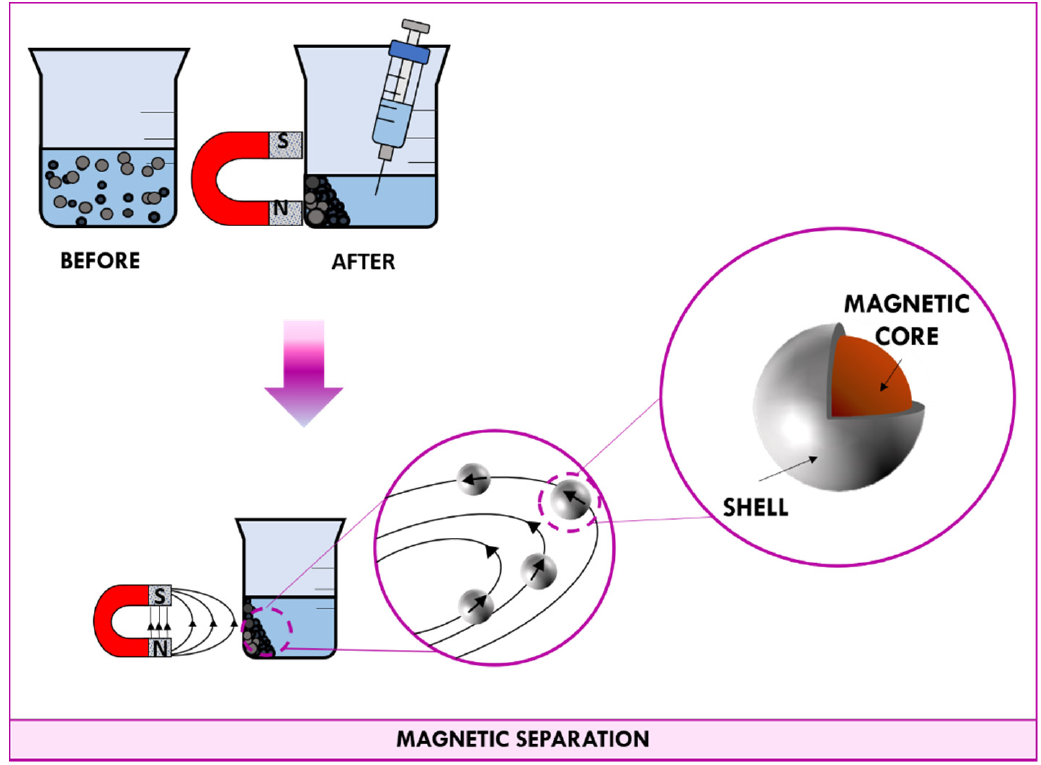
Figure 5. Schematic representation of the magnetic separation.